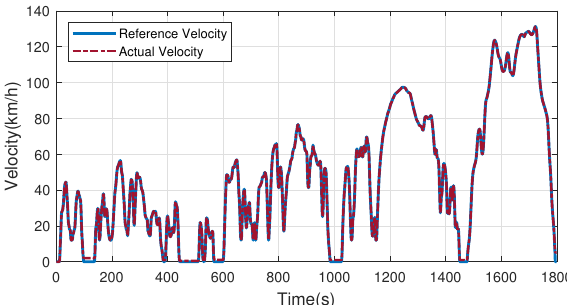
Figure 9. Longitudinal velocity following curve in WLTC condition.